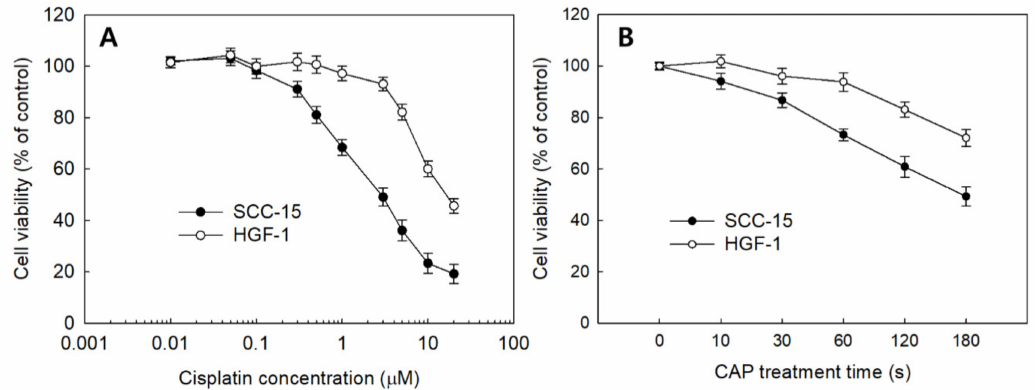
Figure 3. The viability of SCC-15 and HGF-1 cells. ( A ) The e ff ect of cisplatin treatment; ( B ) CAP treatment